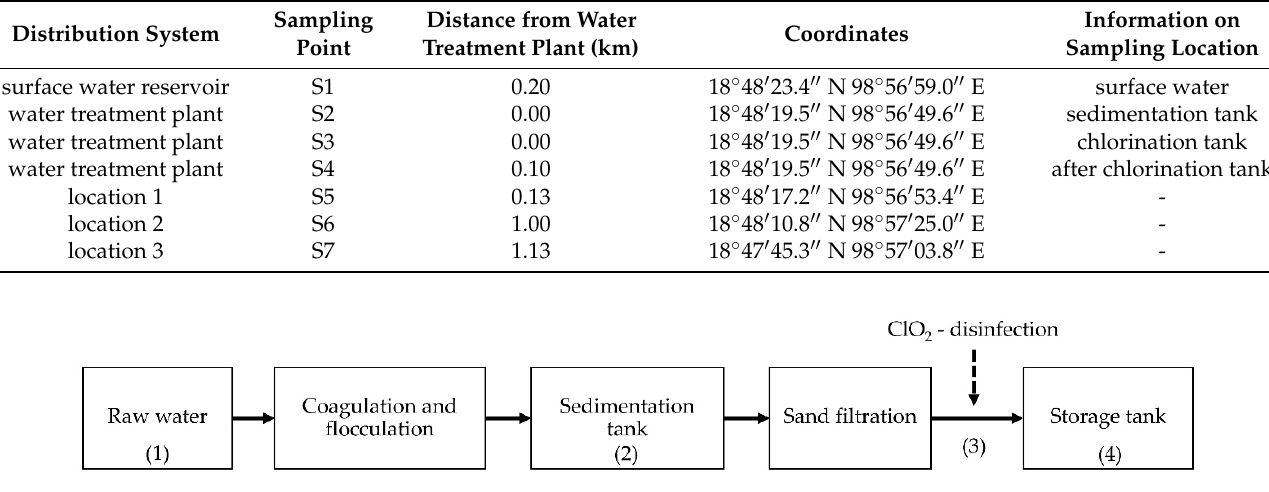
Figure 2. Sampling locations in the water supply system.